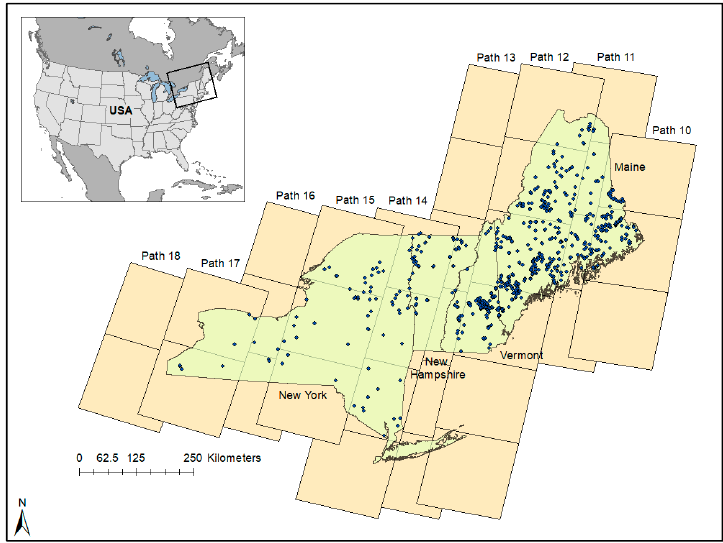
Figure 1. Landsat paths (tan rectangles) and Secchi measurement locations (blue diamonds) across the study region [60].